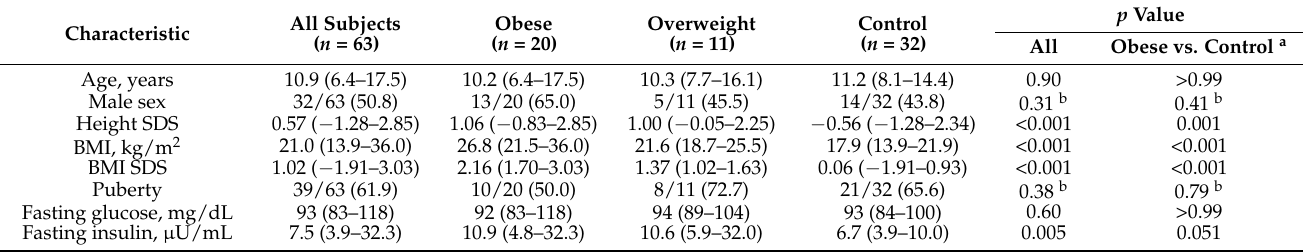
Table 1. Demographic, clinical, and laboratory data for obese, overweight, and control participants.